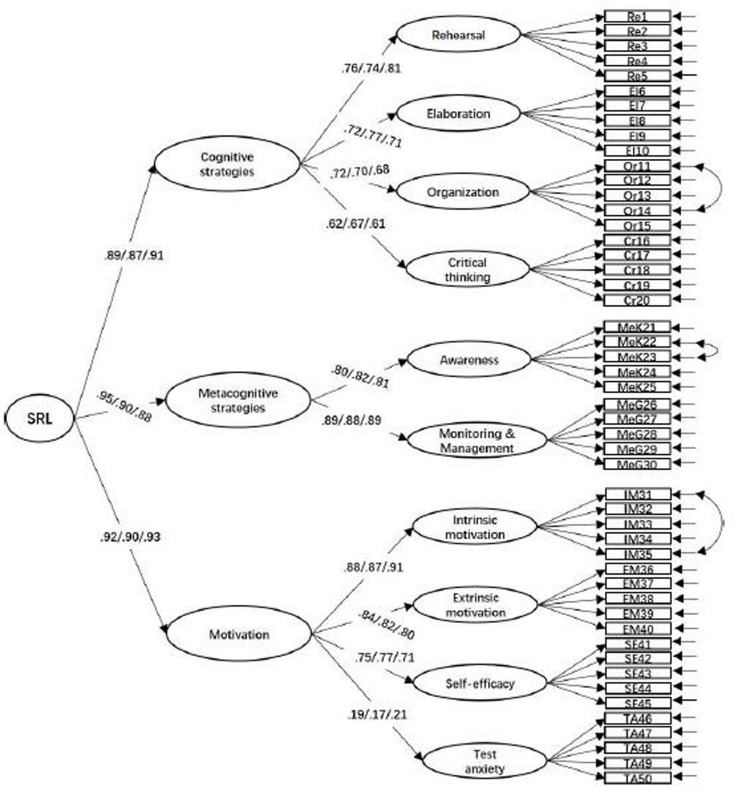
Confirmatory factor analysis of SRL measures.